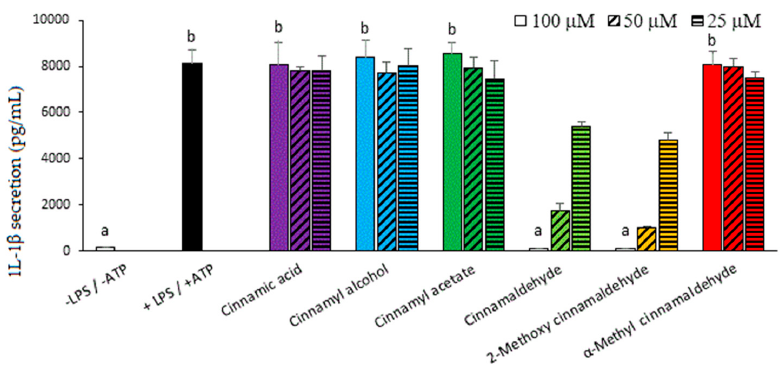
Figure 1. ( a ) Chemical structures of the cinnamaldehyde-related compounds; ( b ) Cytotoxic effect of cinnamaldehyde-related compounds on THP-1 macrophages. The macrophages were incubated with cinnamaldehyde-related compounds at 25~200 μ M for 24 h. The viabilities were then evaluated by MTT method and expressed as % of dimethyl sulfoxide (DMSO) vehicle control. * represents statistically significant differences ( p < 0.05) between treatment group and vehicle control.